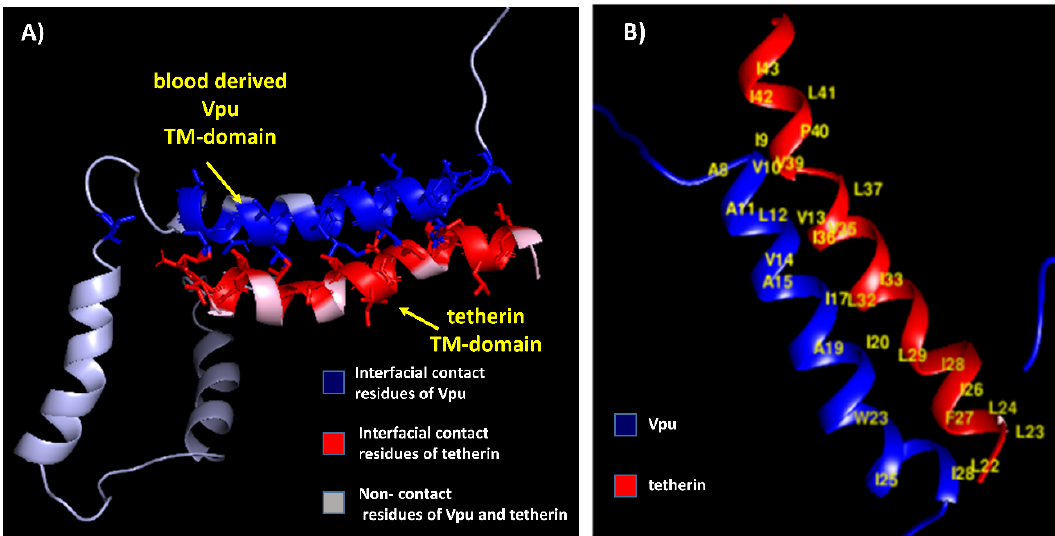
Figure 3. ( A ) Blood-derived Vpu–tetherin complex with interfacial contact residues of Vpu in blue, interfacial residues of tetherin in red, and non-contact residues in grey. ( B ) Residues forming hydrophobic interactions (labeled in yellow) between blood-derived Vpu and tetherin.